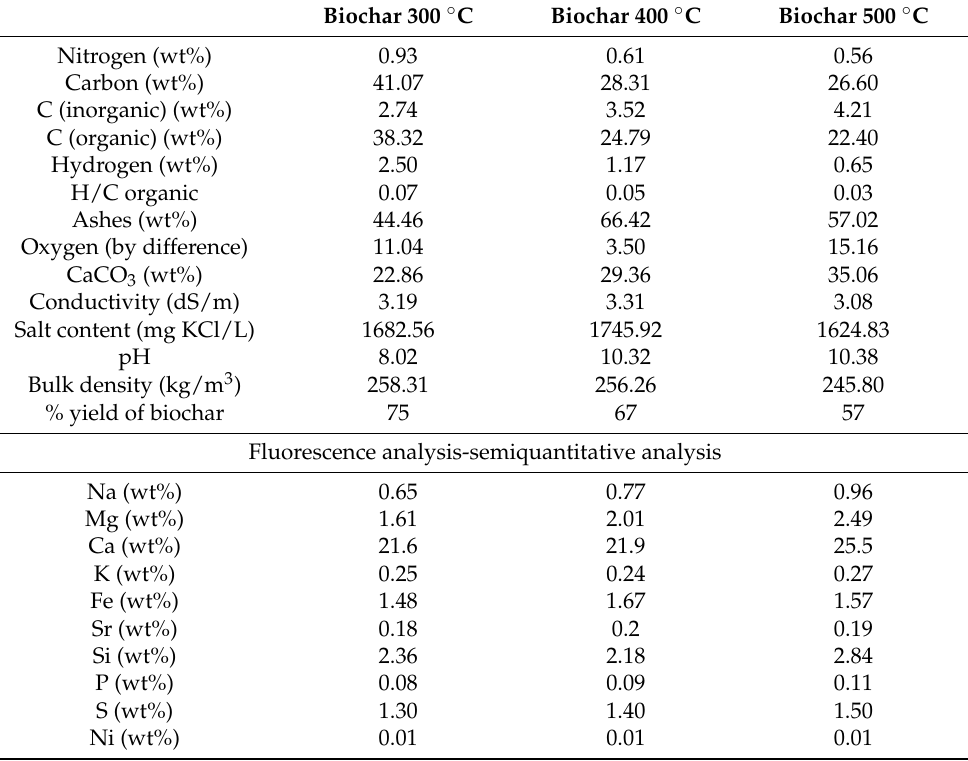
Table 4. Characteristics of the different biochars obtained from washed Posidonia oceanica